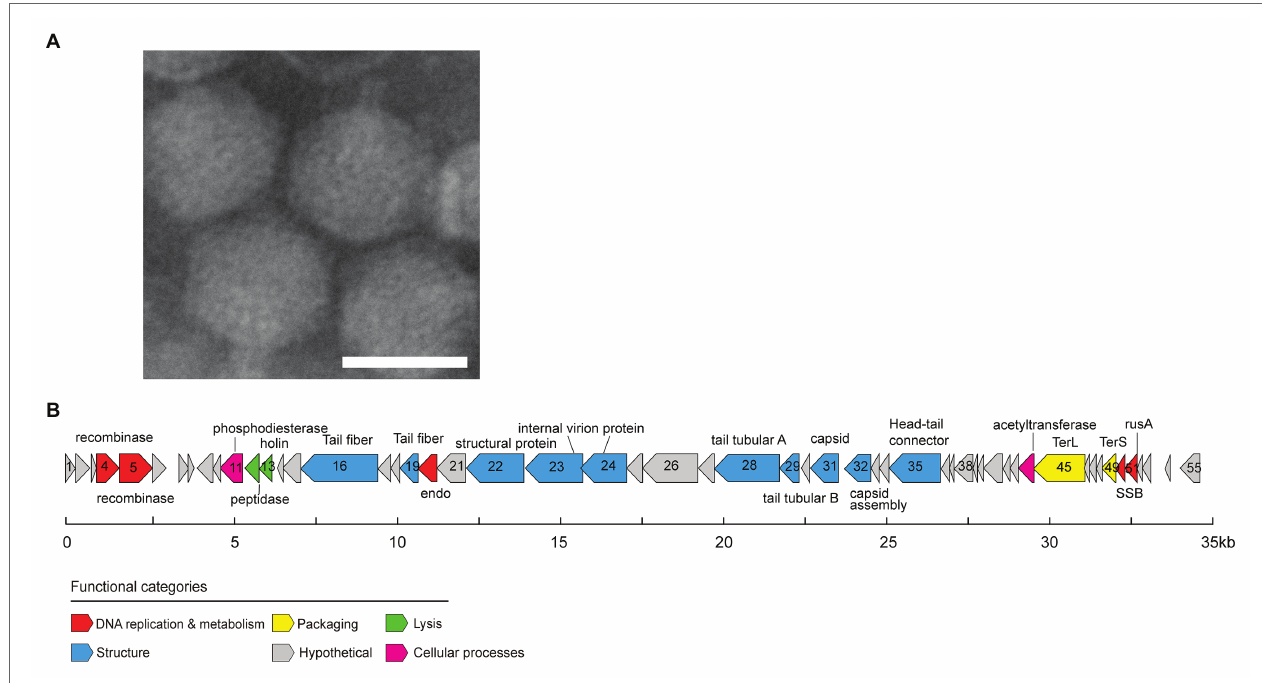
FIGURE 1 | Transmission electron microscopy image of MEP301 (A) . Genome map of MEP301 (B) . Open reading frames (ORFs) are indicated by arrows with the arrow denoting the direction of transcription. ORFs are color-coded according to the putative biological function.